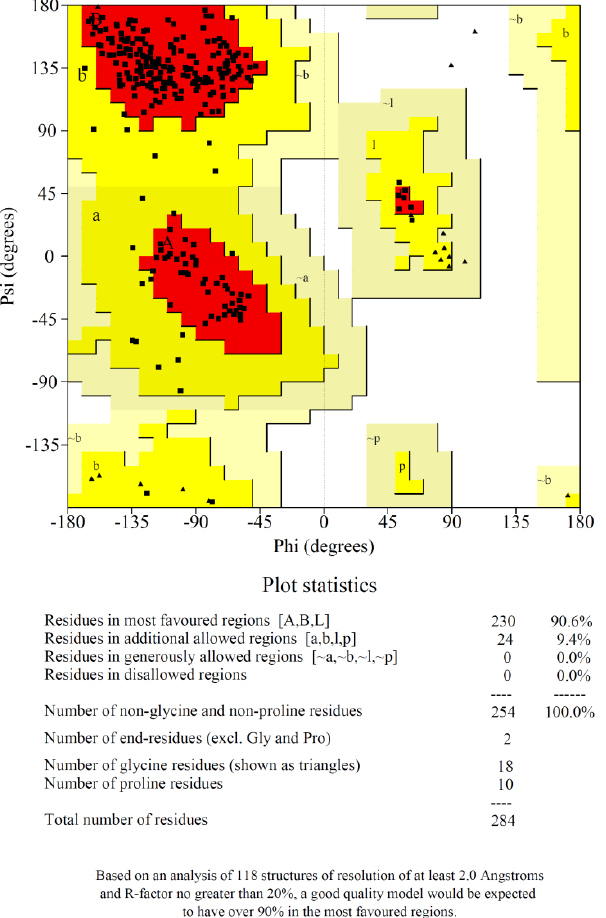
Figure 2. The Ramachandran plot of the selected model. 90.6% of amino acids were located in the most favoured region of the chart (red) which shows that the obtained model was of high quality.